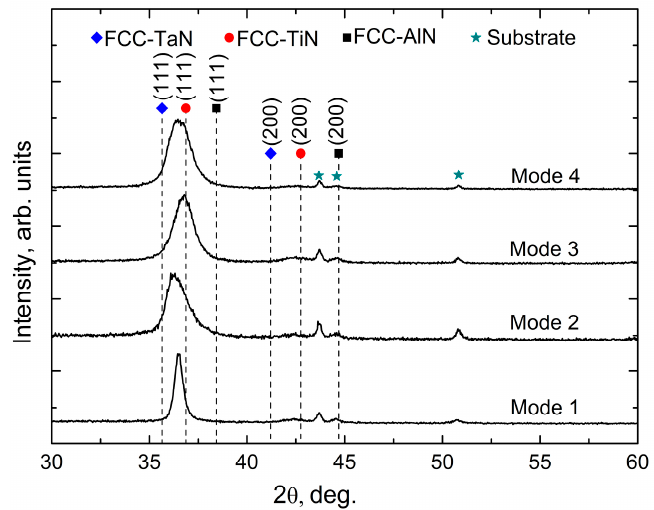
Figure 2. X-ray diffraction patterns of the Ti-Al-Ta-N coatings deposited in different sputtering modes. The positions of FCC TaN, TiN and AlN are indicated according to ICDD 00-046-1200, ICDD 00-038-1420 and ICDD 00-049-1283, respectively.